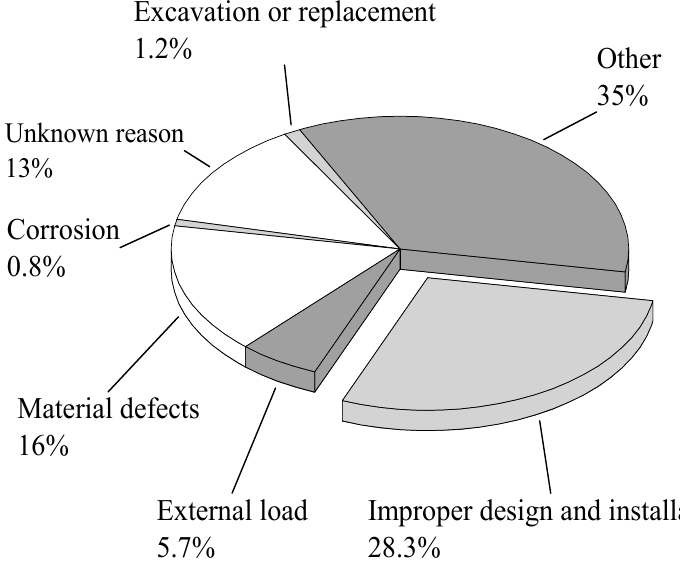
Figure 2. Failure cause of PVC pipes [2].